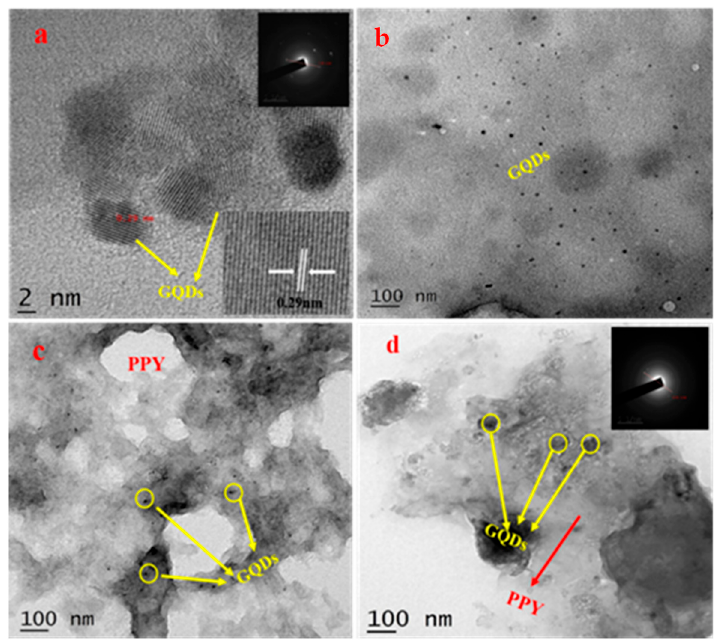
Figure 7. ( a ) HR ‐ TEM image of GQDs. (Inset: HRTEM image of single graphene quantum dots and corresponding SAED pattern) ( b ) The TEM image of GQDs. ( c ) TEM image of PGC2, ( d ) PGC4 composites (inset: SAED pattern of PGC4).